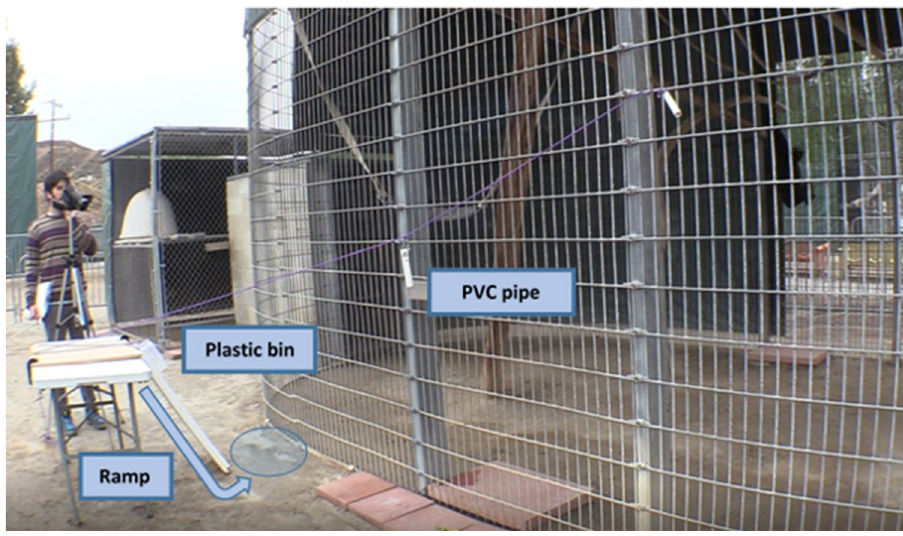
Figure 3. Details of the study setting. The arrow and the circle represent the movement of the food rewards rolling down and the area where the rewards